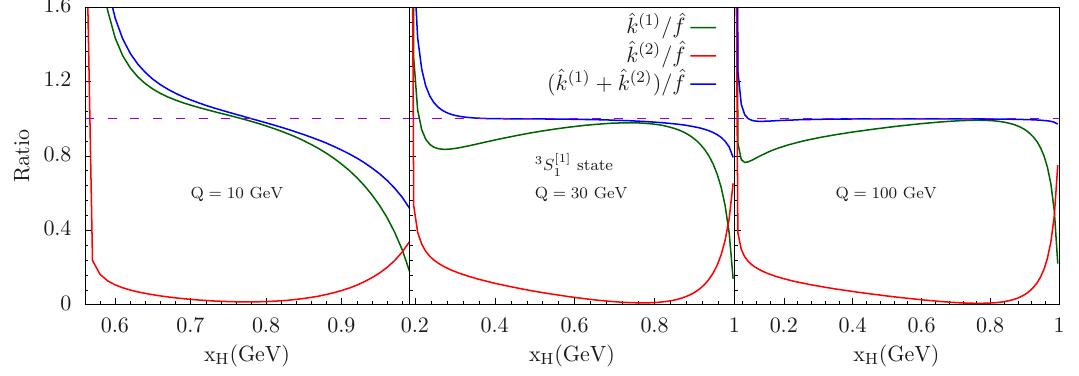
, from eqs. (4.23), (4.24) 1